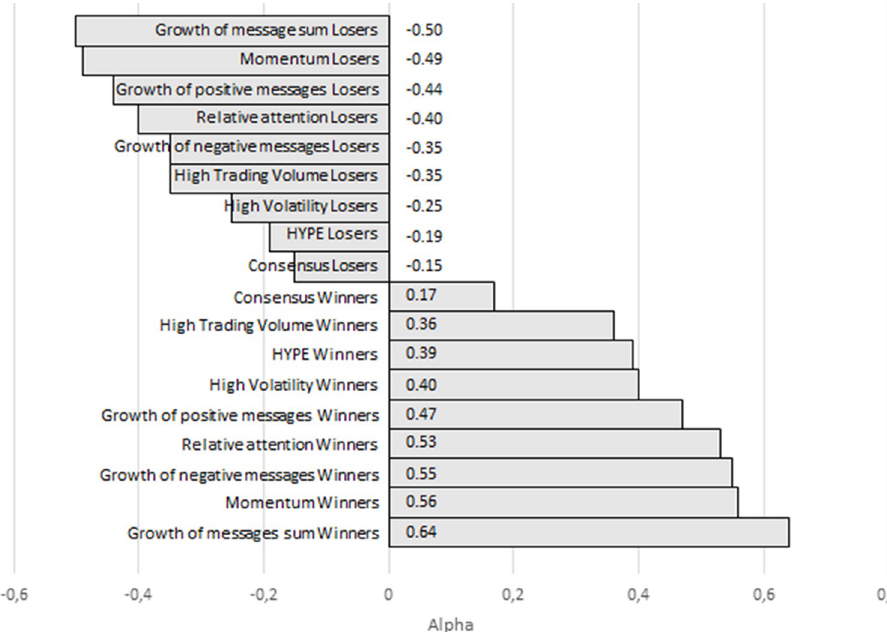
Fig 3. Alphas on each winner and loser portfolio over a short period. Source: the authors’ calculations. Note: Over a short period, the HYPE winner portfolio generated a positive alpha of 0.39. The winner portfolio composed based on the growth of messages generated the best alpha of